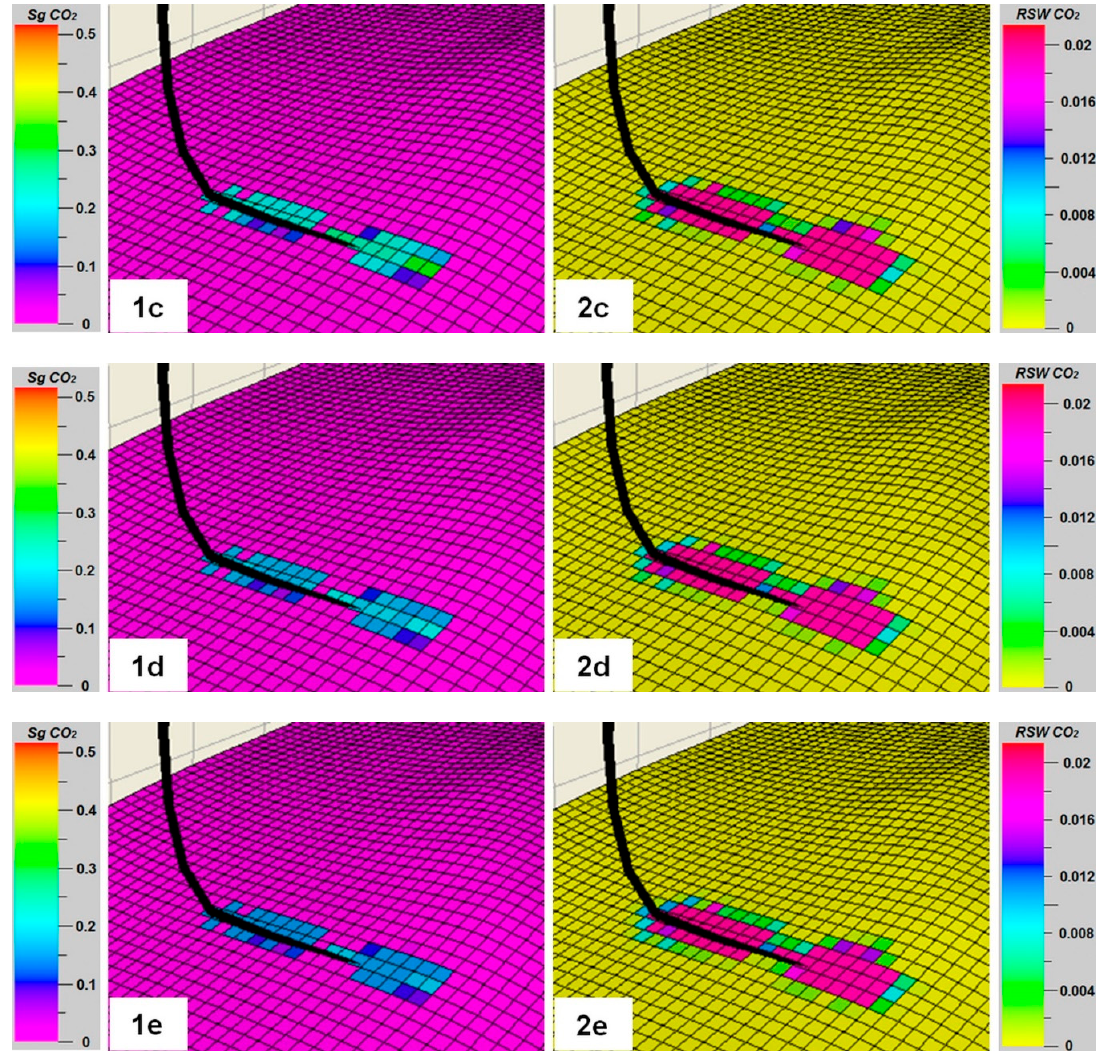
Figure 18. Free CO 2 saturation (1) and distribution of CO 2 dissolved in brine ( RSW CO fraction) (2) in the injected layer of the D ę bowiec formation in the S3A simulation variant after ( a ) 5, ( b ) 25 , ( c ) 50 years from the start of injection and ( d ) 200 and ( e ) 400 years after the end of injection.